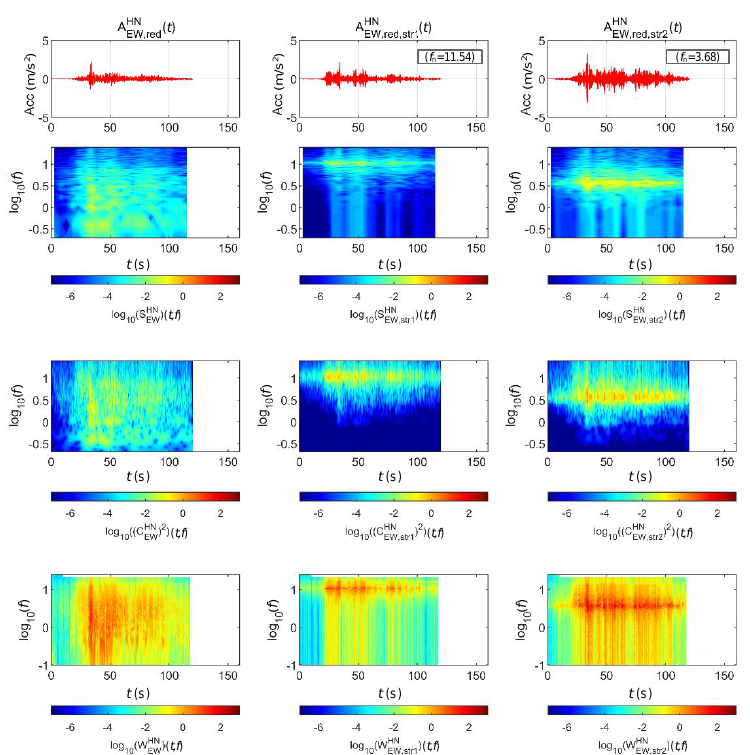
Figure 18. Analysis results of the Hachinohe earthquake data (scaled for 2400-year return period) and associated bridge response.